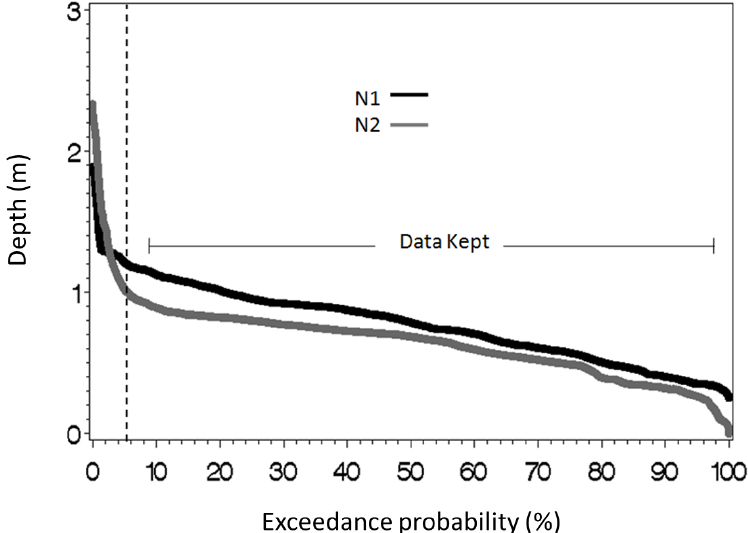
Figure 3. Exceedance-probability curves based on all depths (m) recorded (15-min increments; from 2006 to 2010) at N1 (black) and N2 (gray). The vertical, dashed line represents the 5% mark that was used to discard high-flow data. All data taken at depths to the left of this line were